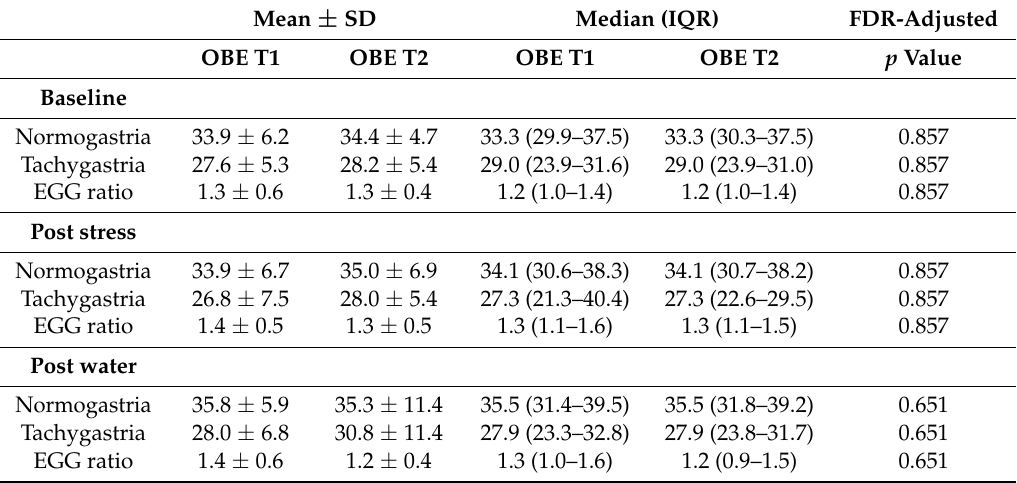
Table 4. EGG data of children with obesity (OBE) before (T1) and after (T2) weight